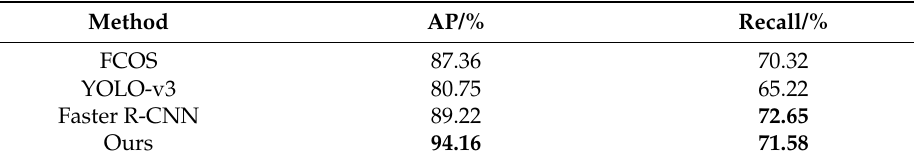
Table 3. The results of different models on test datasets.